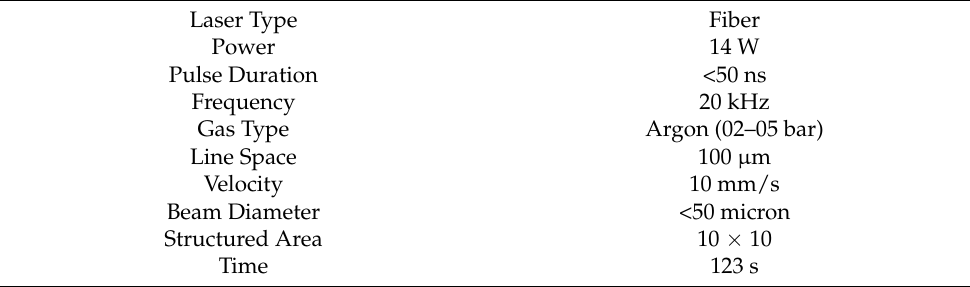
Table 2. Laser system parameters used in experimental